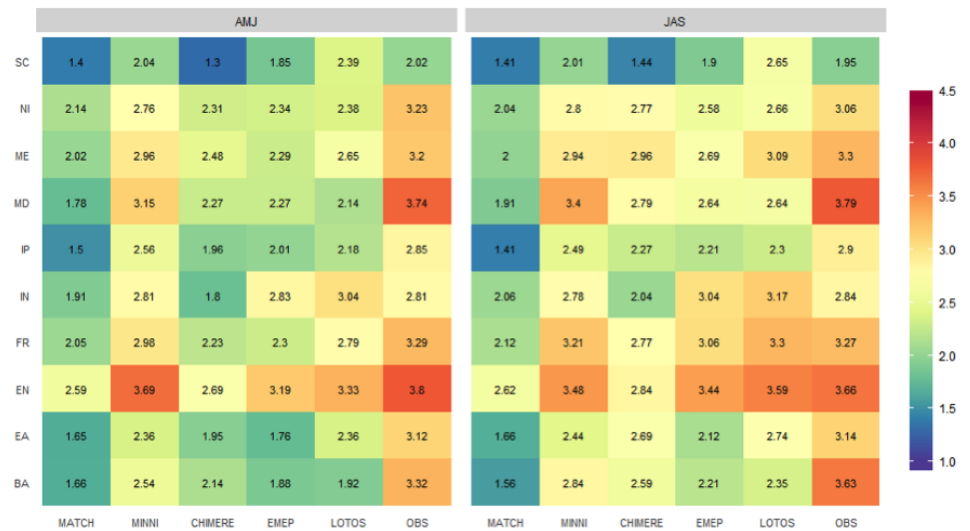
Figure 5. Root mean square errors (RMSE) for each CTM-based (ordered as in Fig. 3) and observation-based MLR at each region, in spring (AMJ) and summer (JAS).